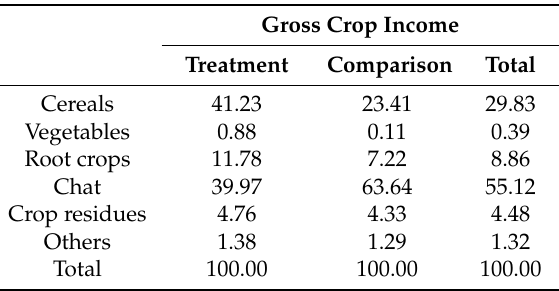
Table 3. Contribution of various crops to gross crop income (percentage